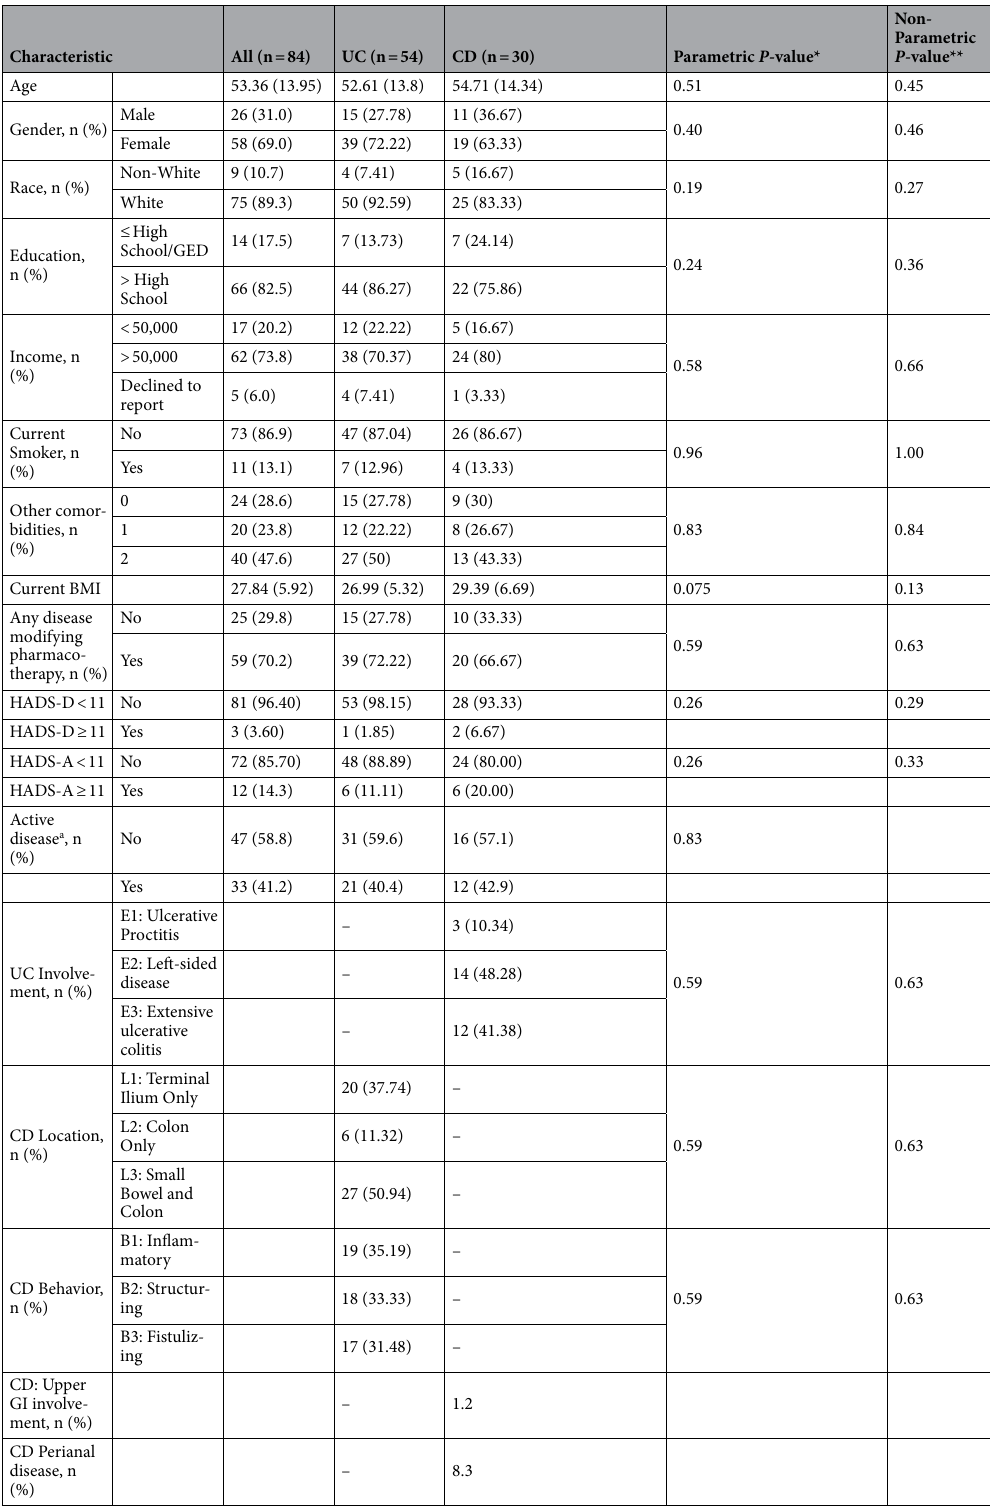
Table 1. Descriptive statistics of the entire IBD sample, ulcerative colitis and Chron’s disease (CD) subgroups; Mean (SD). a = 4 missing. *The parametric P -value is calculated by ANOVA for numerical covariates and chi- square test for the categorical covariates. **The non-parametric P -value is calculated by the Kruskal– Wallis test for numerical covariates and Fisher’s exact test for categorical